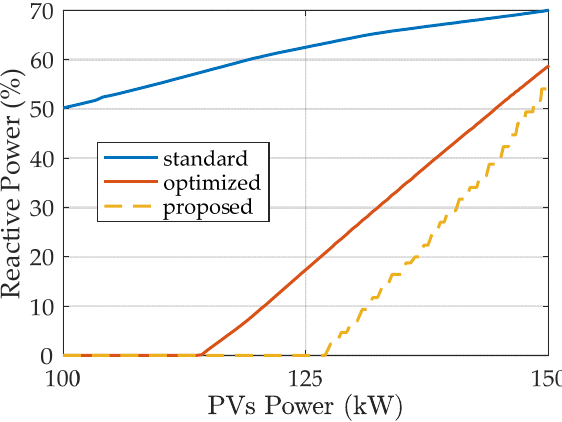
Figure 9. Percentage absorbed reactive power at di ff erent active power levels.